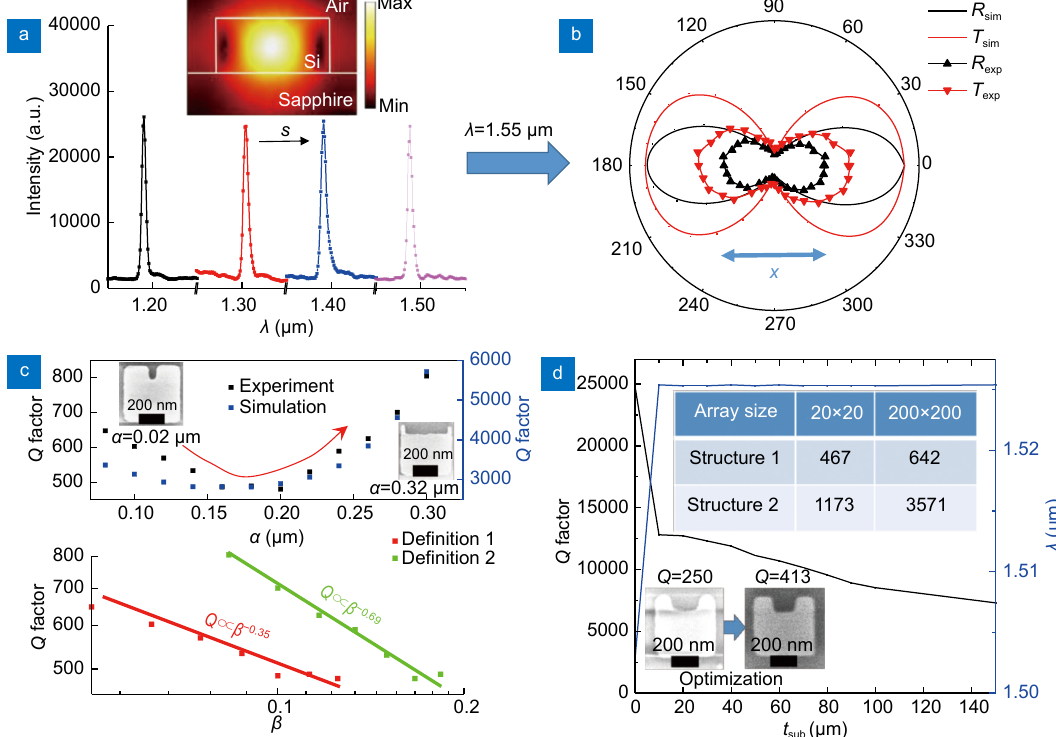
Fig. 3 | ( a ) Measured transmission spectrum at different s (20×20 array). Inset: The magnetic field distribution in the yz plane for the metasurface with the substrate. ( b ) Polarization dependence measurements of the transmission ( T exp ) and reflection ( R exp ) spectra at a wavelength of 1.55 μm and their corresponding calculations (i.e. T sim and R sim ). The arrow indicates the direction of the x -axis. ( c ) Top: Modeled the calculated and measured Q factor as a function of a ( s =1.2 and b =0.1 μm). Inset: SEM image of the single unit at a =0.02 μm and a =0.32 μm, respectively. Bot- tom: The evolution of Q factor at different α for two definitions (log-log scale). ( d ) Numerically simulated dependence of the resonant wavelength and Q factor on t sub ( t sub =0 μm means that there is no substrate). The top inset shows the comparison of the measured Q factor for different di- mensions and array sizes. Structure 1: l =0.4 μm, a =0.15 μm, b =0.1 μm, and s =1.15. Structure 2: l =0.5 μm, a =0.1 μm, b =0.1 μm, and s =1.02. The bottom inset shows the SEM images of the prepared structures before and after the process